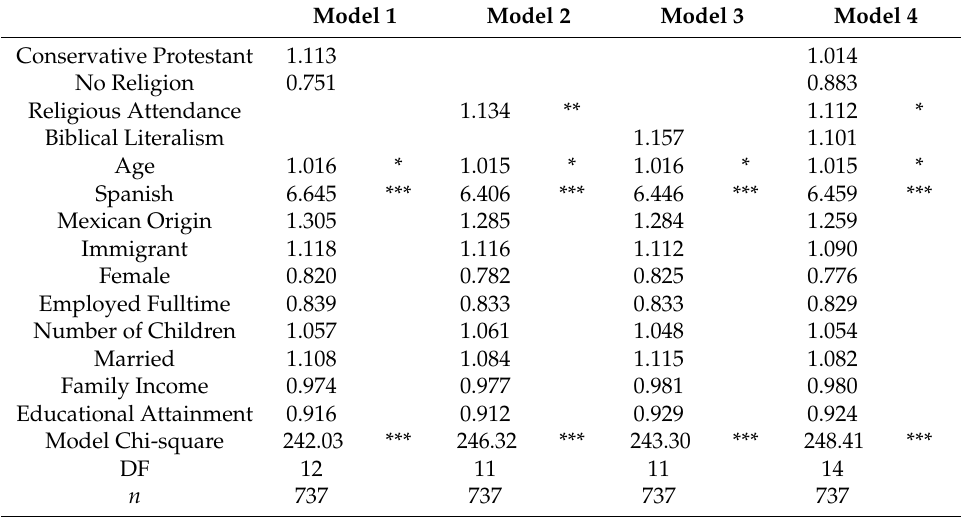
Table 2. Odds Coefficients of Ordered Logit Models Predicting Female Domesticity: ‘Preschool Children Are Likely to Suffer If Their Mother Works’.